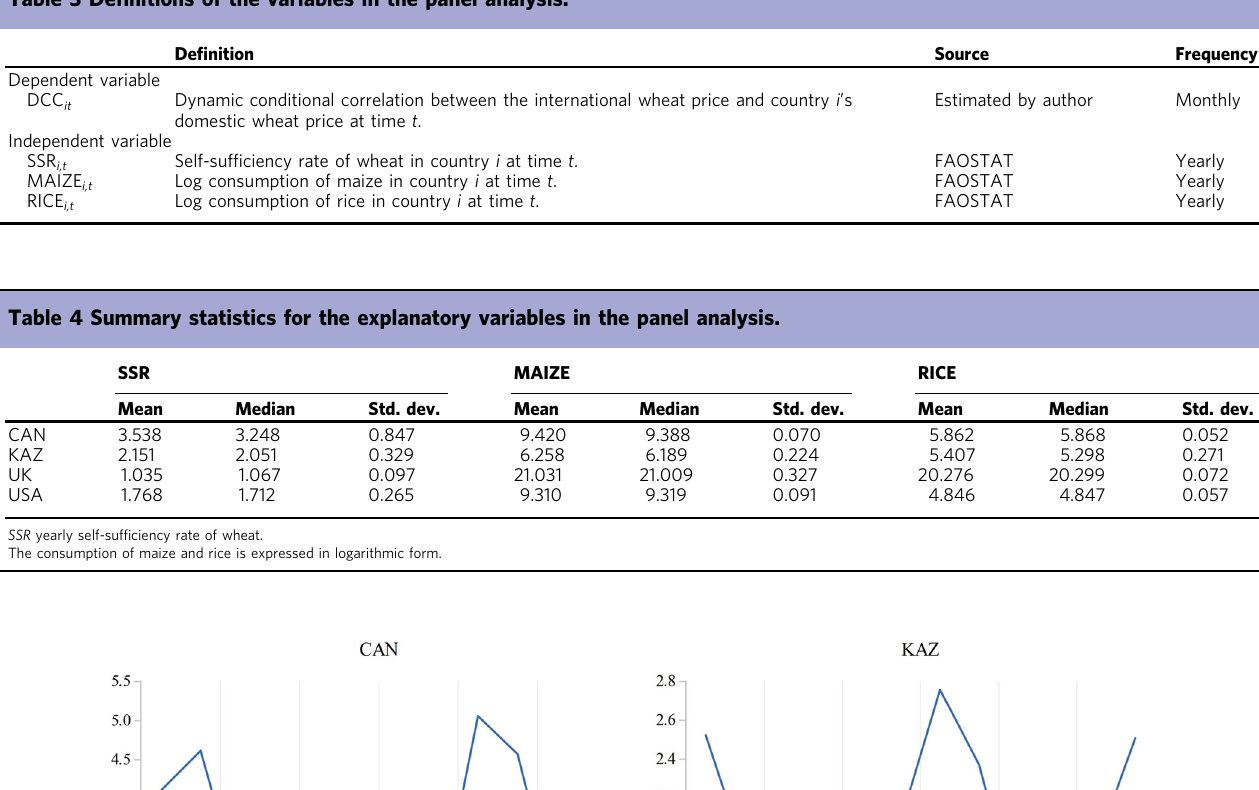
Table 3 De fi nitions of the variables in the panel analysis.